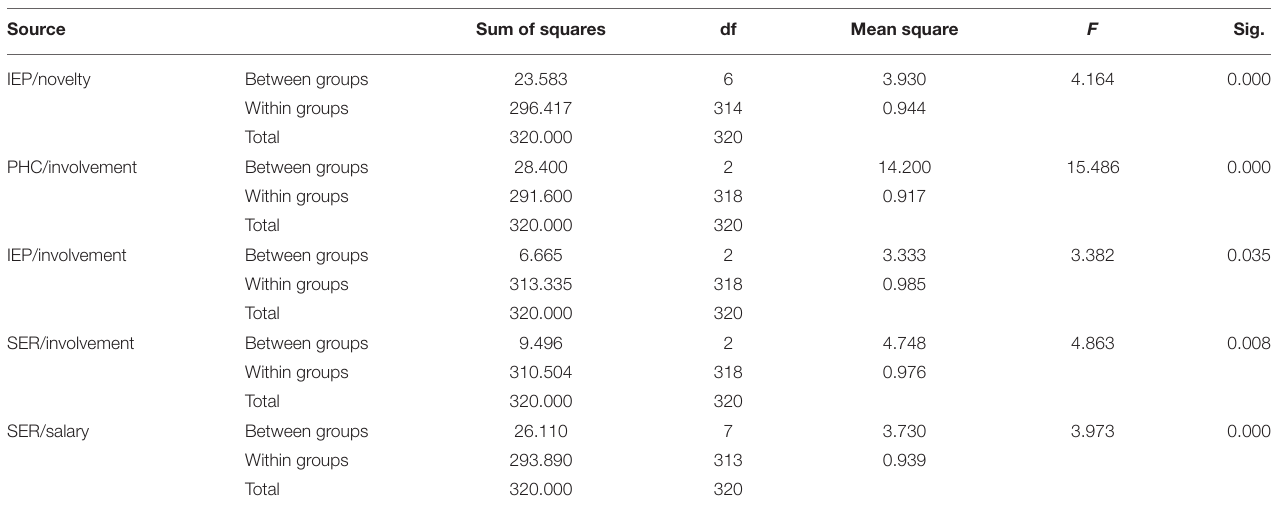
TABLE 5 | One-Way ANOVA for constraints perception in different